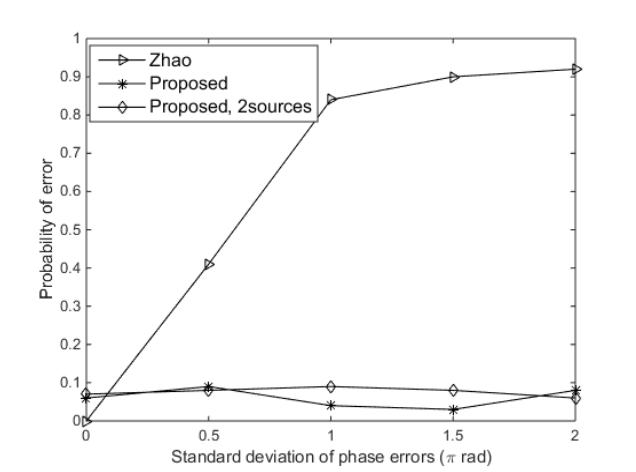
Figure 5. Probability of error versus the standard deviation of phase errors.